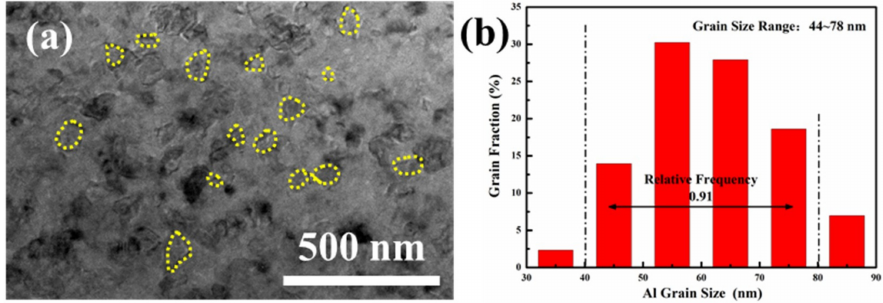
Figure 9. ( a ) S30 transmission electron microscopy (TEM) micrograph and ( b ) Distribution histogram of aluminum grain